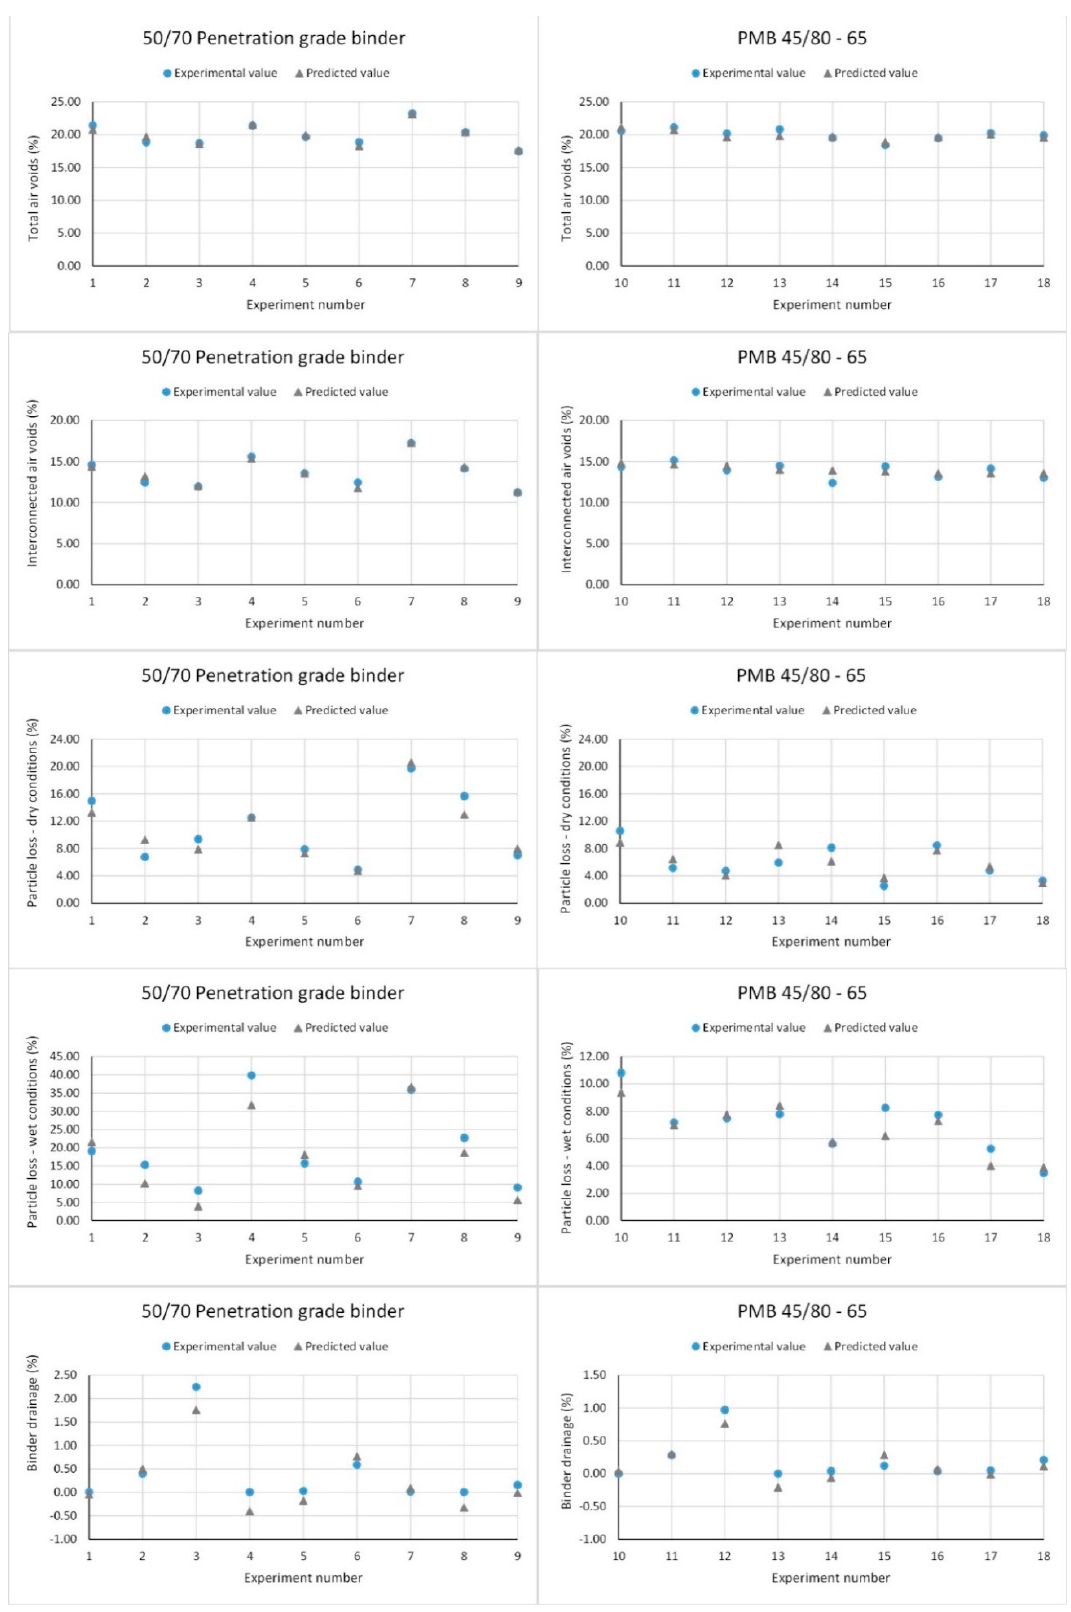
Figure 10. Experimental vs. predicted values of the different response variables.